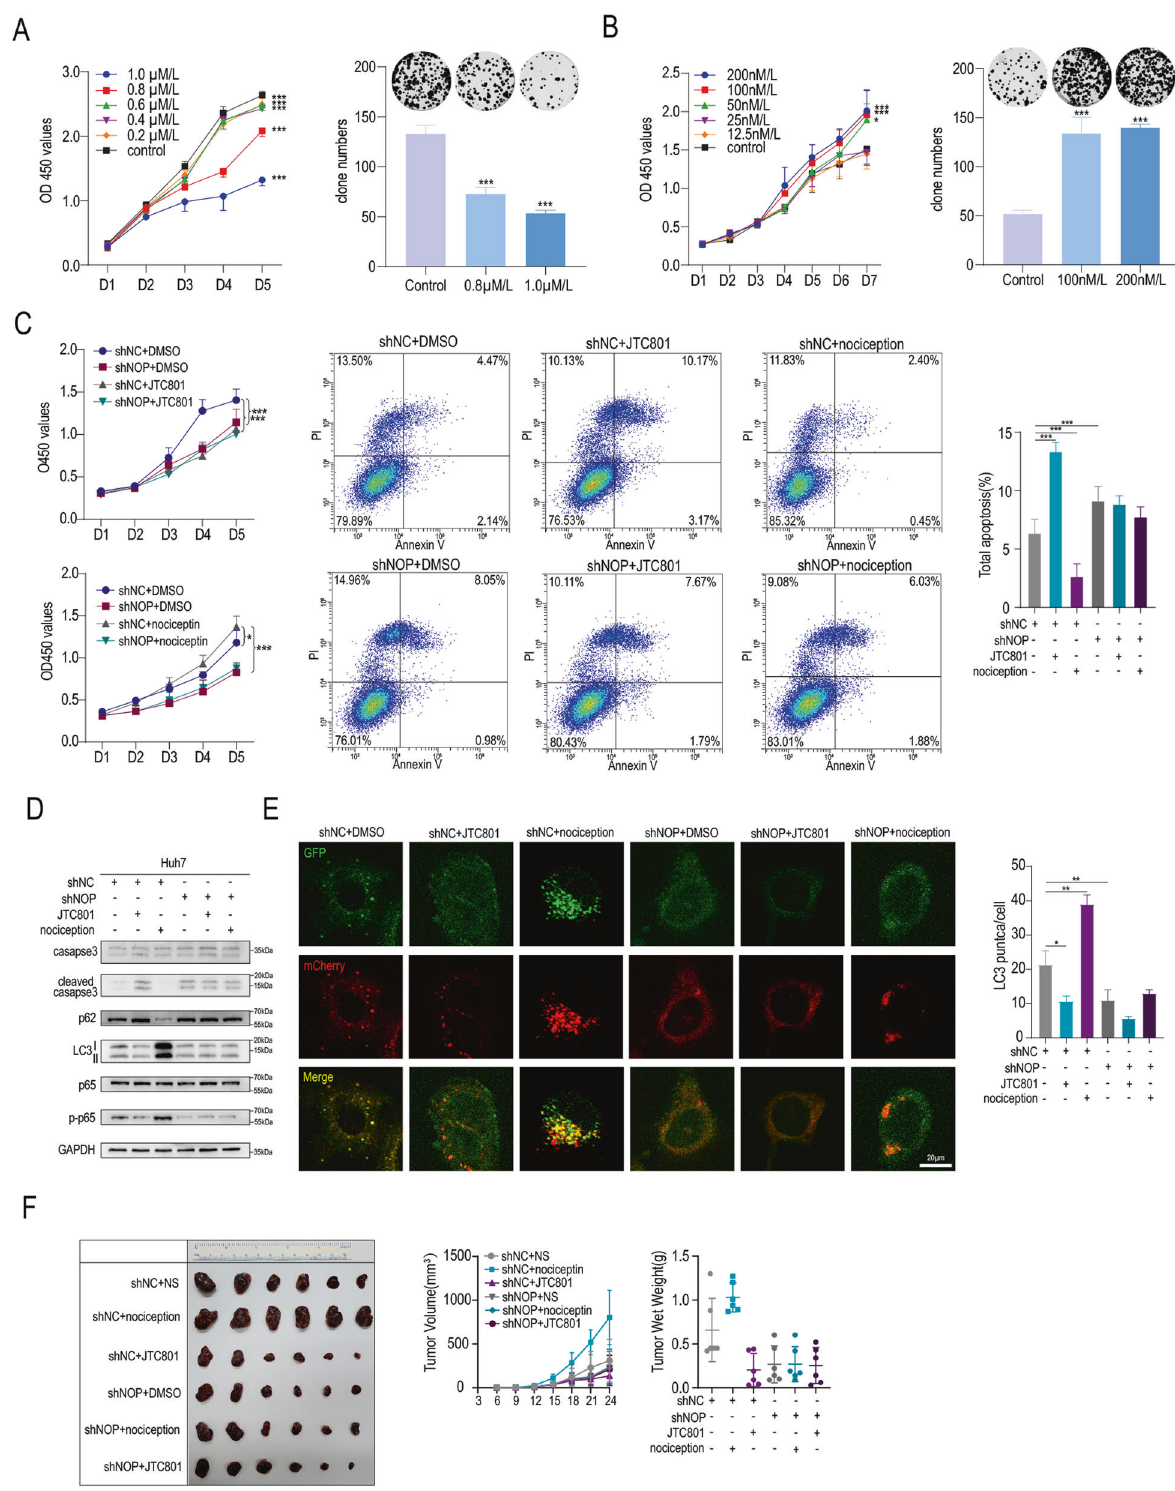
Fig. 6 JTC-801 suppresses HCC progression through the NOP-autophagy pathway. A CCK-8 and colony-formation assays showing the proliferation of HCC cells treated with various concentrations of JTC801. B CCK-8 and colony-formation assays showing the proliferation of HCC cells treated with various concentrations of nociceptin. C CCK-8 assay and apoptosis analysis showing the proliferation of shNC and shNOP HCC cells treated with DMSO, JTC-801 or nociceptin. D IB analysis of the indicated proteins associated with NF-kB, autophagy, and apoptosis in Huh7 cells treated with JTC-801 or nociceptin. E IF staining showing LM3 expression in shNC and shNOP HCC cells treated with JTC-801 or nociceptin. Scale bars = 20 μ m. F shNC and shNOP HCC cell-derived xenograft tumors in mice treated with JTC-801 or nociceptin. *** P < 0.001, ** P < 0.01, * P < 0.05.